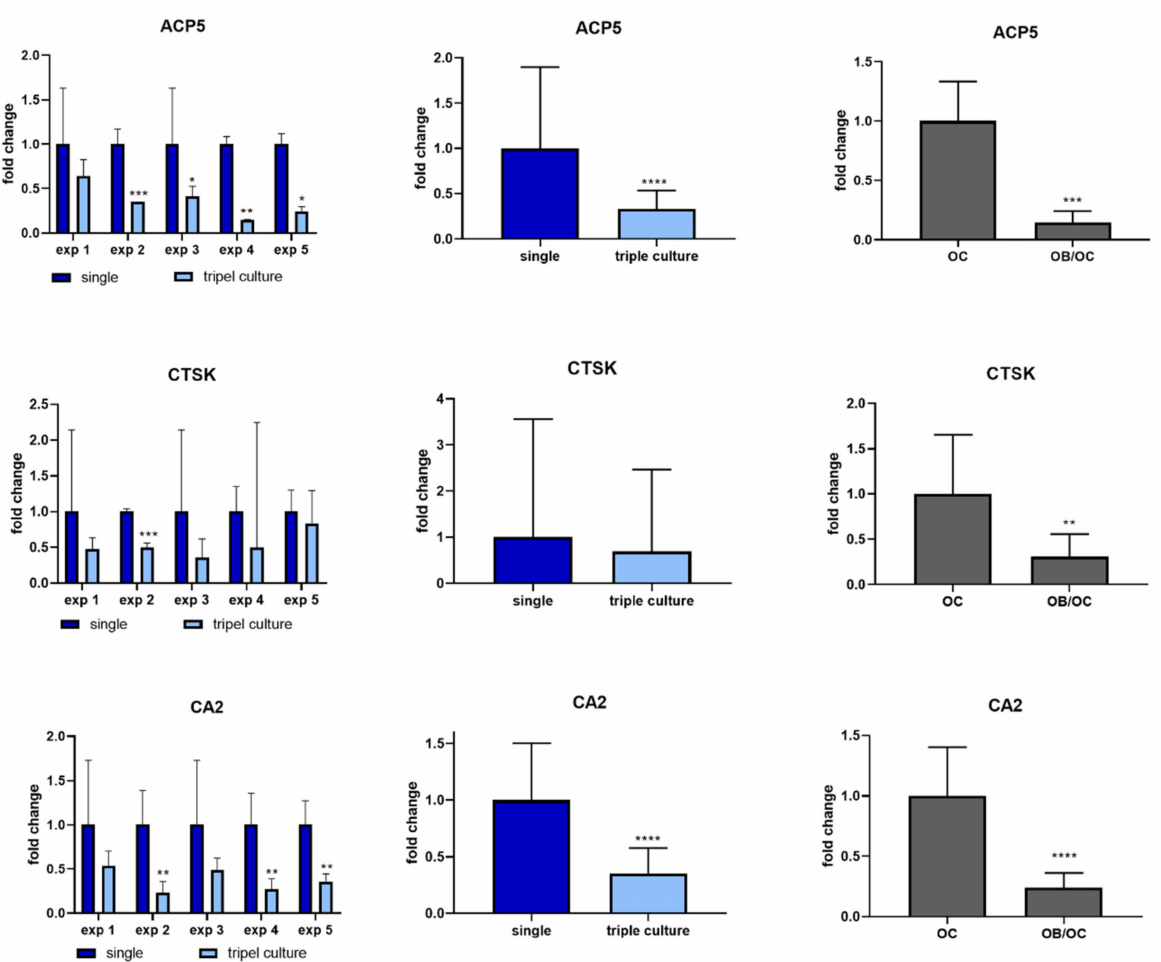
Figure 4. Gene expression analysis of osteoclast marker genes ACP5, CA2 and CTSK for osteoclasts cultivated in single culture compared to triple culture (left and middle column) and in co-culture with osteoblasts (right column). Gene expression was normalized to the expression of GAPDH and fold changes were calculated using the CT method. Fold changes +/ − upper and lower limits are given for every triple culture experiment (left column) for all five triple culture experiments together (middle column). Additionally, osteoclasts, derived from two different donors were combined with osteoblasts of one donor in two independent experiments in co-culture (right column) * p < 0.05; ** p < 0.01, *** p < 0.001, **** p <